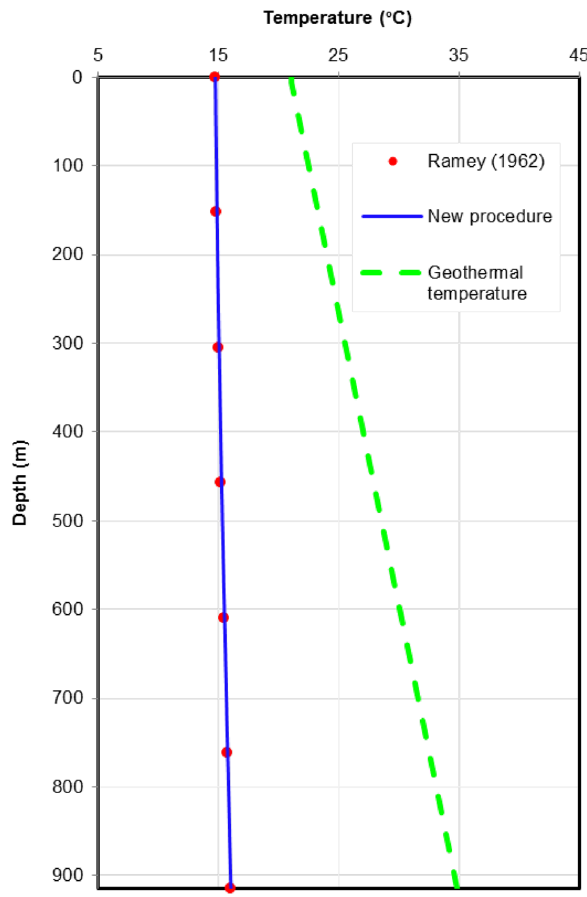
Fig. 6 Comparison of temperature distribution with well depth from Ramey Jr (1962) and predicted by the new procedure